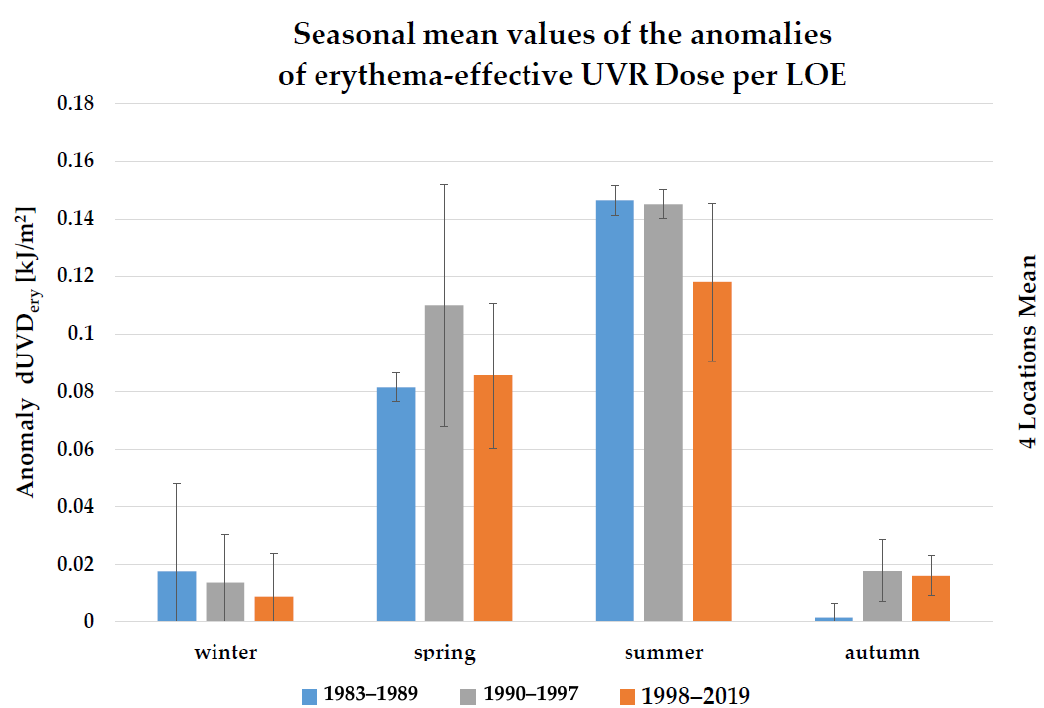
Figure 10. Seasonal mean values of the anomalies of the erythema-effective UVR dose per event during the subperiods T1 (1983–1989), T2 (1990–1997), T3 (1998–2019) (4-location means and stand- ard deviations).